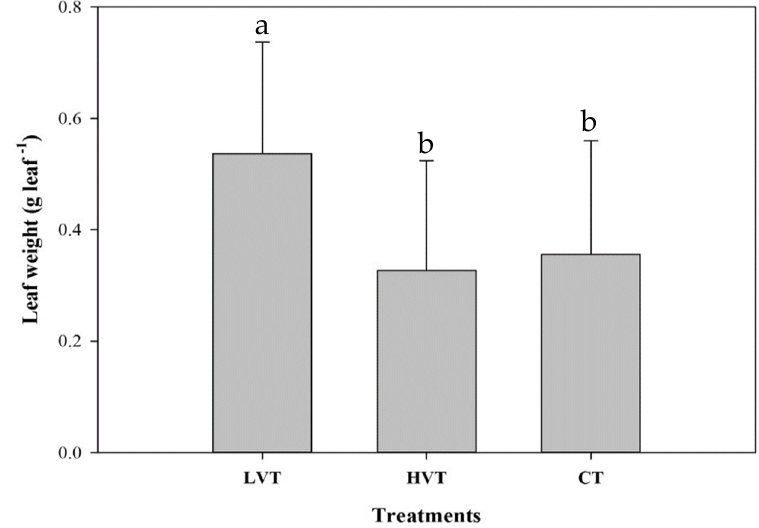
Figure 10. The average leaf weight for strawberries for each treatment. Means followed by the same letter are not significantly different ( p < 0.05, Scheffé test). LVT is the low-temperature oscillation pattern, HVT is the high-temperature oscillation pattern, and CT is the fixed temperature regime.